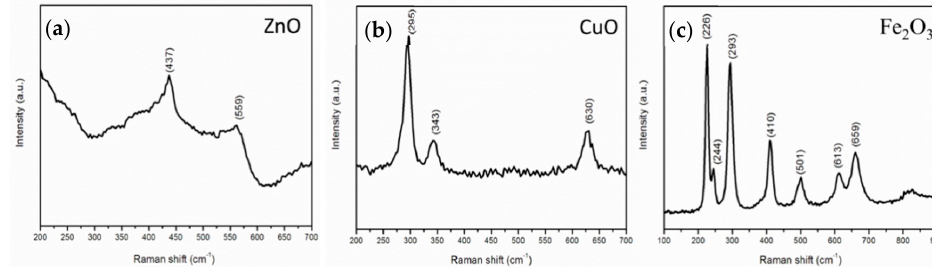
Figure 6. Characteristic Raman spectra of the ZnO nanostructures ( a ), CuO nanostructures ( b ), Fe 2 O 3 nanostructures ( c ), produced at a processing temperature of 450 °C, 300 °C, 600 °C, respectively.